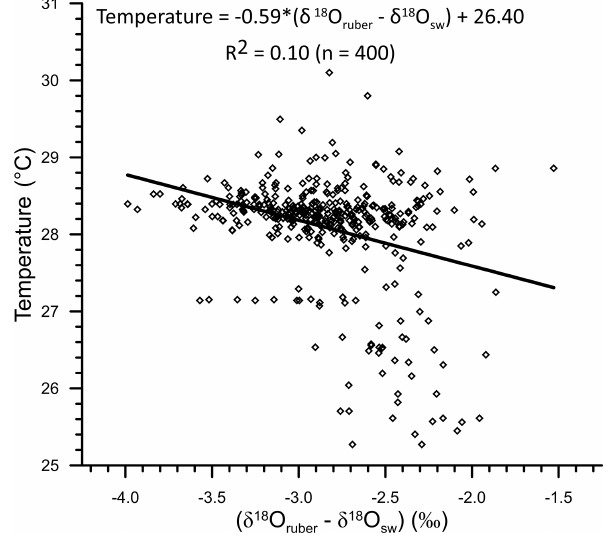
Figure 13. The relationship between ambient temperature and ( δ 18 O ruber − δ 18 O sw ) for the northern Indian Ocean. As expected, the ( δ 18 O ruber − δ 18 O sw ) becomes enriched in heavier isotopes with decreasing ambient